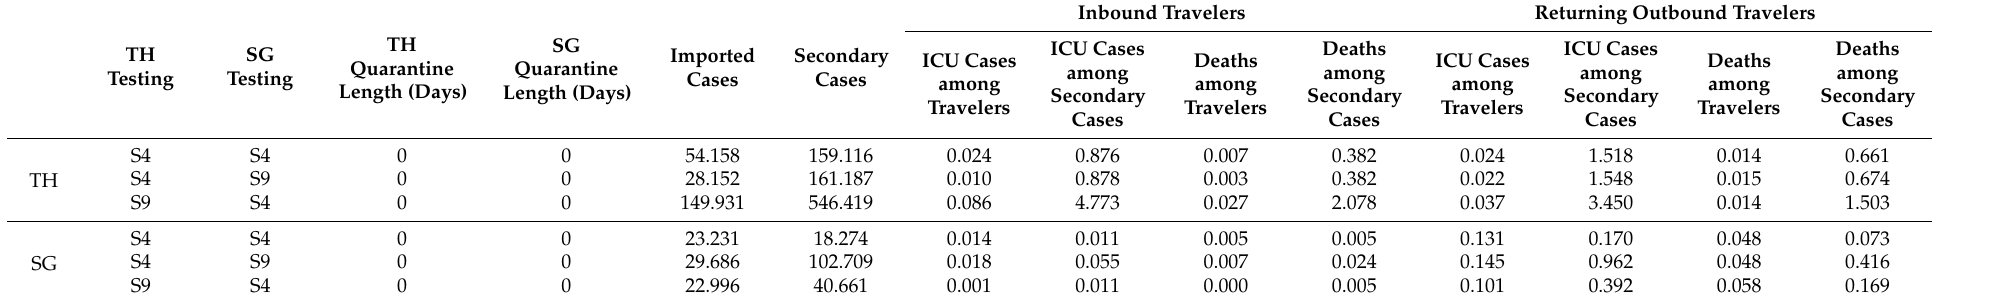
Table 3. Transmission results under Pareto optimal policies (all numbers are per-month